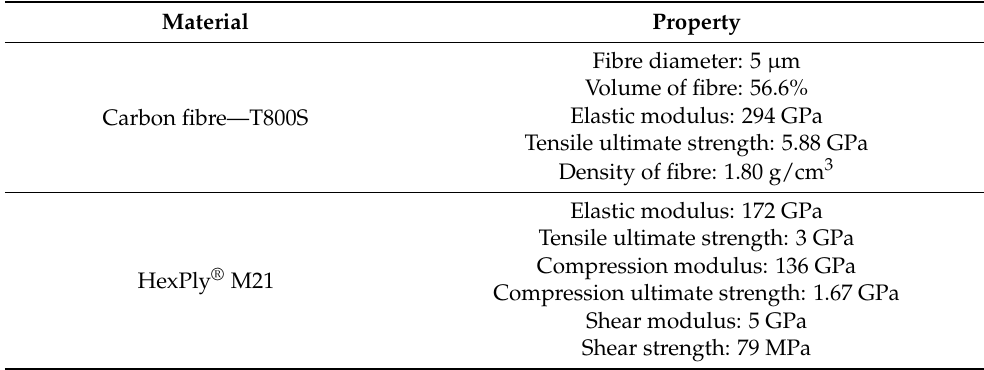
Figure 1. A schematic of the composite preparation and the cutting process ( a ) CFRP Prepeg sheets, ( b ) Vacuum Bagging, ( c ) Autoclave Curing, ( d ) Cutting Configuration. Table 1. Properties of fibre and matrix phases in UD-CFRP [19,20].